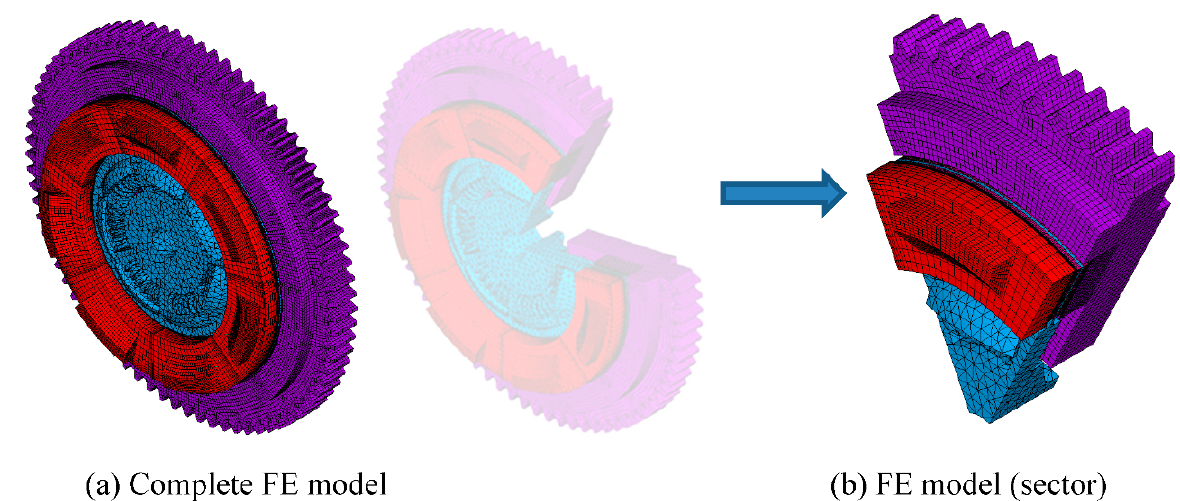
Figure 6. 3D FE model of frictional clutch. ( a ) Complete FE model; ( b ) FE model (sector). Table 1. The material properties and working parameters of clutch system [5].